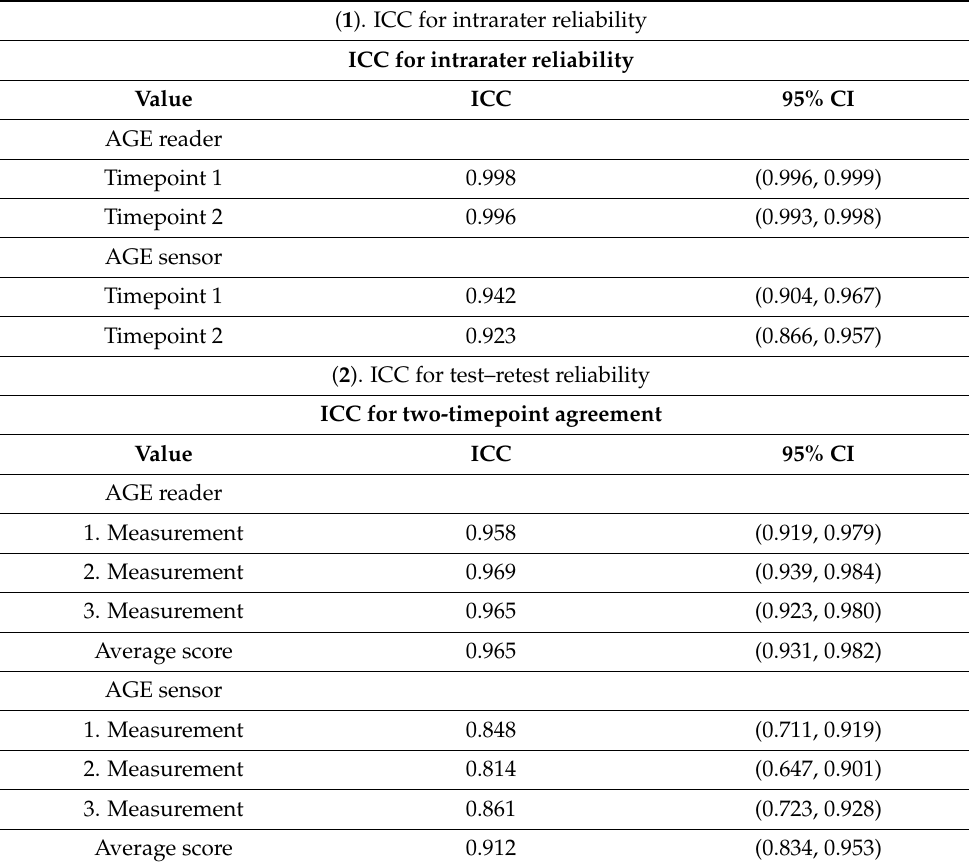
Table 3. ( 1 ). ICC for intrarater reliability.( 2 ). ICC for test–retest